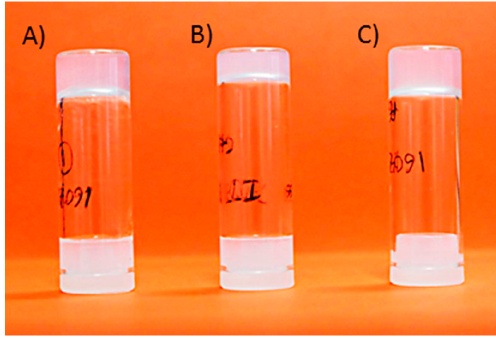
Figure 2. Hydrogel formation at 1% ( A ); 3% ( B ); and 4% ( C ) ( w / v ).